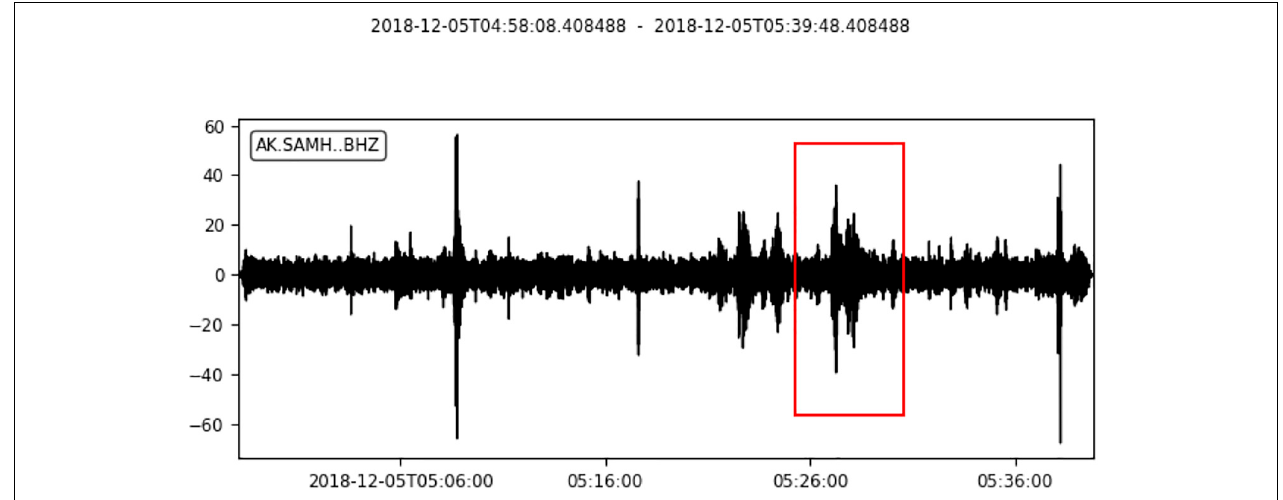
FIGURE 9 | Example seismogram with a triggered earthquake (red box) hidden in high background